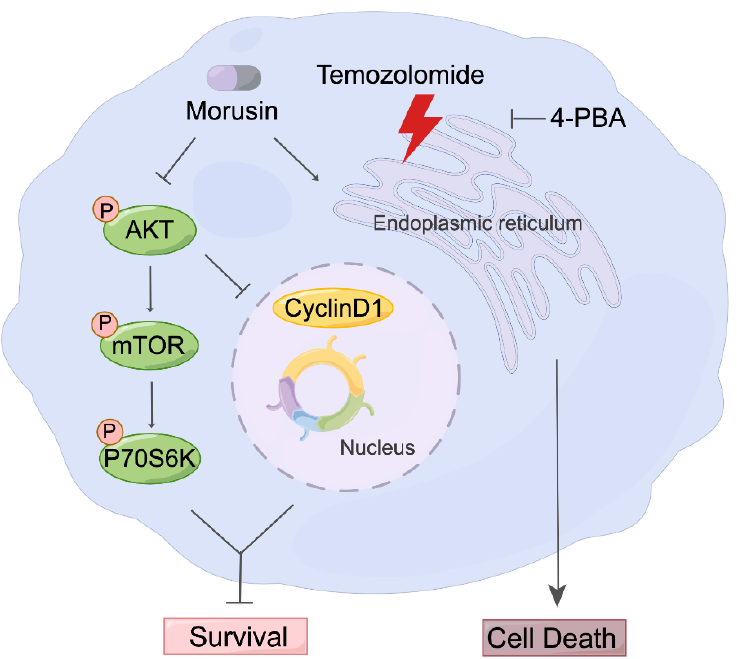
Figure 7. Schematic depicting the effect of morusin on GBM cells and the underlying